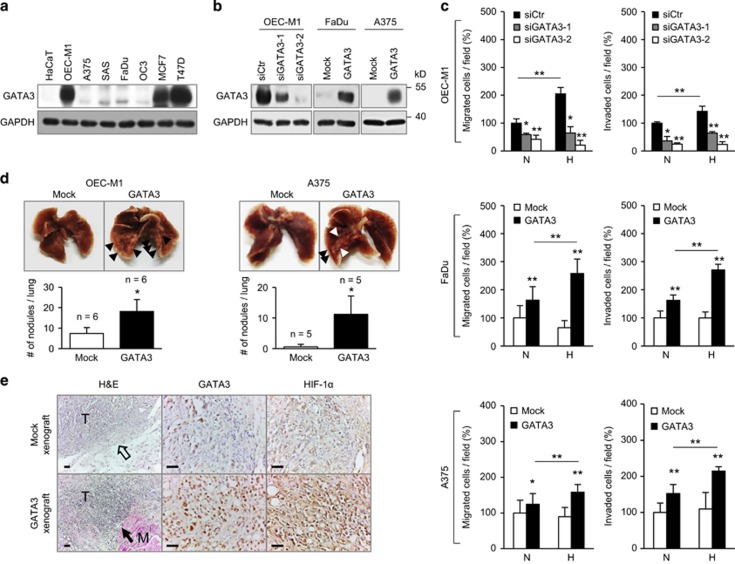
GATA3 promotes tumour invasiveness in vitro and in vivo. (a) Western blot analysis of GATA3 expression in various cell lines as indicated. GAPDH was an internal control. (b) Knockdown and overexpression of GATA3 were confirmed by western blot analysis. For knockdown, OEC-M1 cells were transfected with non-targeting siRNA (siCtr) or two independent siRNAs against GATA3 (siGATA3-1 and siGATA3-2). For overexpression, FaDu and A375 cells were transfected with empty pcDNA3.1 (Mock) or GATA3/pcDNA3.1 (GATA3). (c) Effects of GATA3 on cell migration and invasion analysed by transwell migration and Matrigel invasion assays, respectively. Cells were seeded after transfection for 48 h. Normoxia (N, O2=21%) or hypoxia (H, O2=1%) is as indicated. Results are represented as mean±s.d. from three independent experiments. *P<0.05, **P<0.01. (d) Effects of GATA3 on experimental metastasis in vivo. Upper panel, representative images of lungs and metastatic tumour nodules indicated by arrowheads. Lower panel, statistical analysis of tumour nodules. Mock or GATA3 overexpressing OEC-M1 and A375 stable transfectants (1 × 106 cells / per injection) were injected through tail veins into NOD-SCID mice (n=6 and 5, respectively). Results are represented as mean±s.d. Data are analysed by Student’s t-test. *P<0.05. (e) Expression of GATA3 and HIF-1α in subcutaneous tumour xenografts. Left, hematoxylin and eosin staining. The hollow arrow indicates the intact capsule separating the tumour from surrounding tissues. The black arrow indicates the invasion of tumour into skeletal muscles. M, skeletal muscle. T, tumour. Middle and right, immunohistochemical staining of GATA3 and HIF-1α. Scale bars, 50 μm.